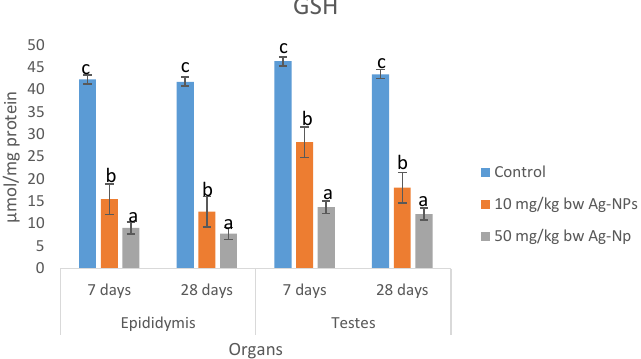
Figure 6. Effects of sub-dermal administration of Ag-NPs on GSH activity in the testis and epididymis of rats. Each bar represent mean ± standard deviation of triplicate determination. Bars with different superscript alphabet are significantly different ( p < 0.05). The high significant levels of the parameters were in the order of a < b < c. Data with superscript alphabet “a” are significantly lower than data with superscript alphabet “b” while data with superscript “b” are lower than data with superscript alphabet “c” at p < 0.05.